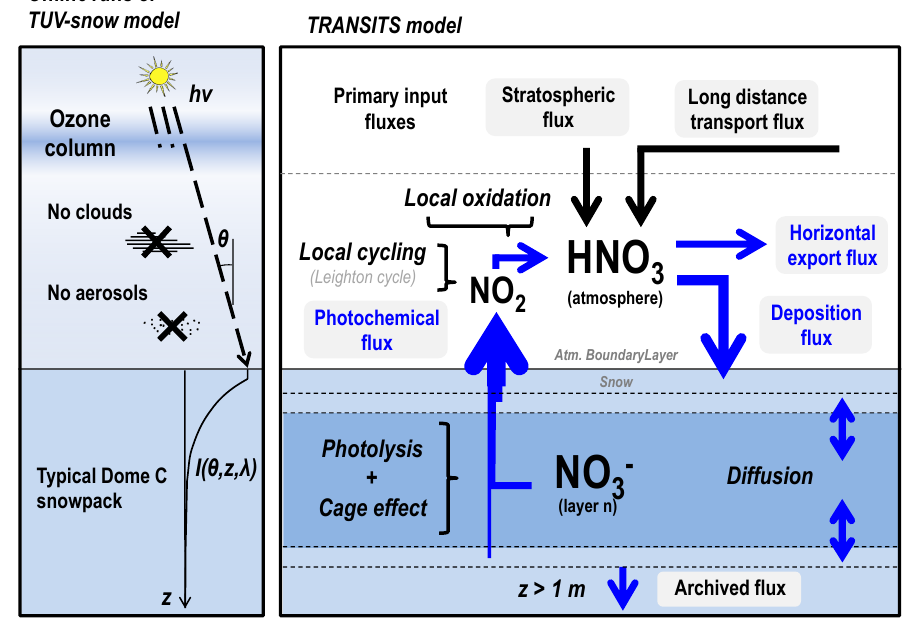
Figure 1. Overview of the TRANSITS